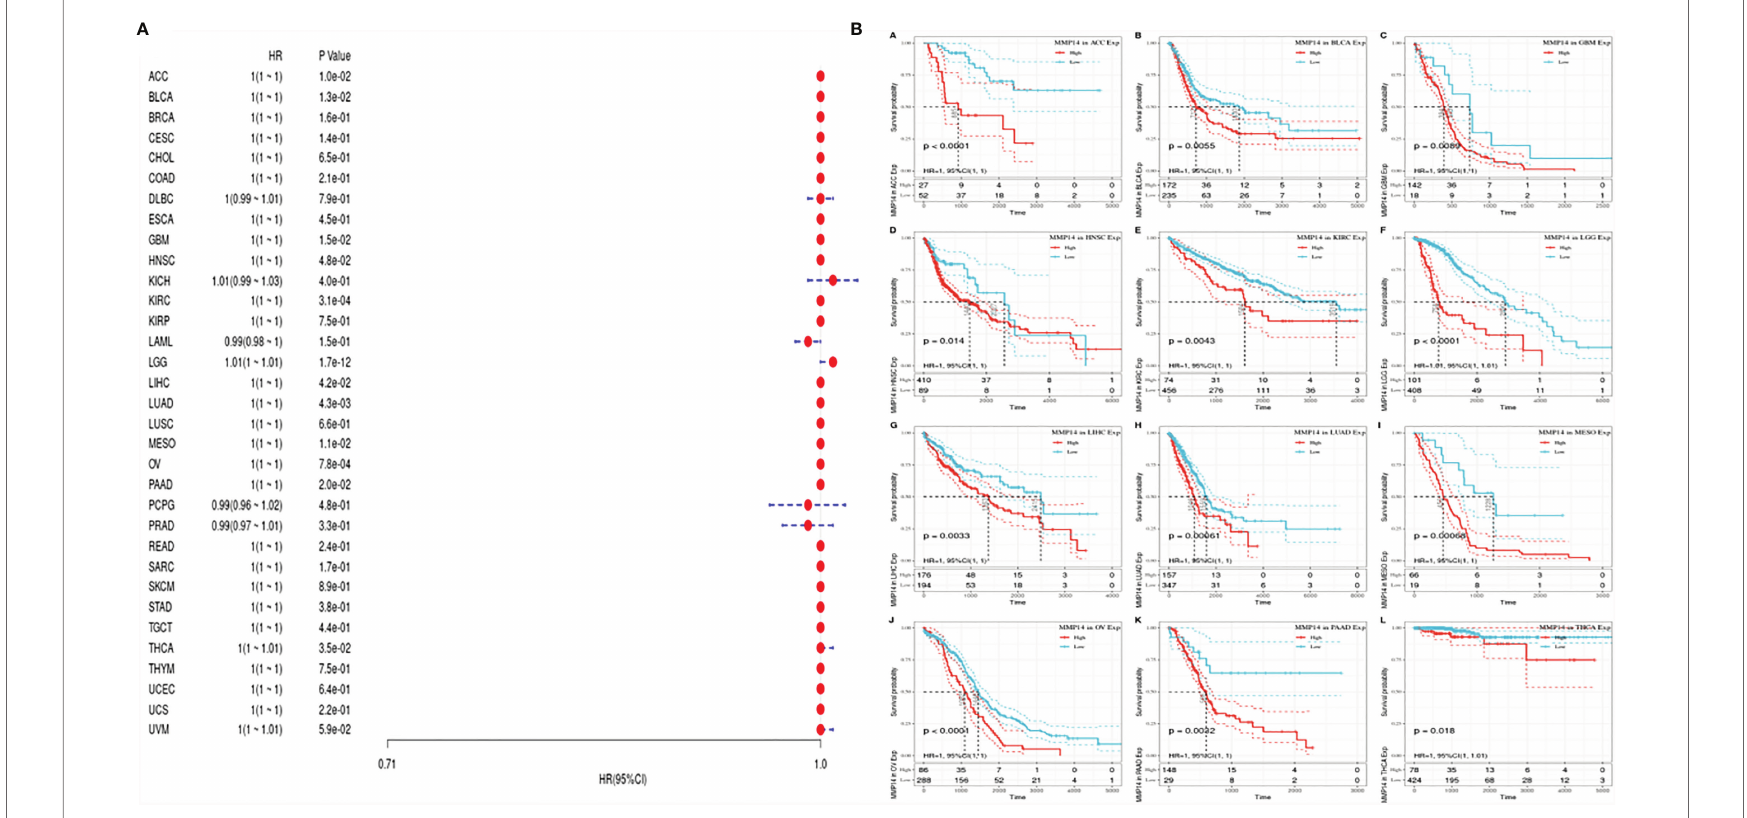
FIGURE 2 | The relationship between the expression of matrix metalloproteinase 14 (MMP14) and the overall survival (OS) and prognosis of pan-cancer was analyzed. (A) The correlation between MMP14 expression and OS in different cancer types of The Cancer Genome Atlas (TCGA) was analyzed. The red part represents the risk ratio. Due to the limited sample size, the parameters and hazard ratio could not be calculated with short bars, and the red font indicates p < 0.05. (B) Kaplan – Meier analysis was used to generate a survival curve for the prognostic effect of MMP14 expression on pan-cancer. OS, overall